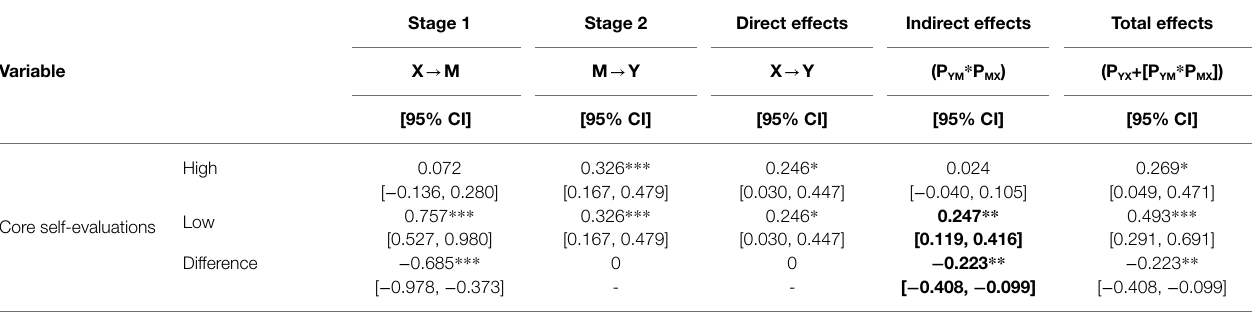
TABLE 4 | Analysis results of moderated mediation effect (core self-evaluations).